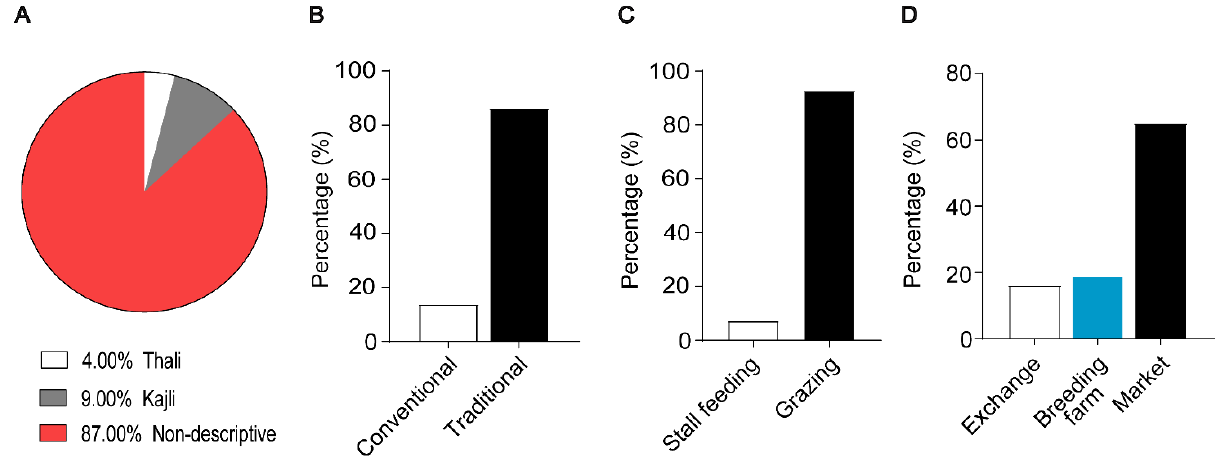
Figure 2. Sheep Flock distribution and production systems: ( A ) Flock distribution ( B ) Sheep production system ( C ) sheep feeding system. ( D ) Sheep source.